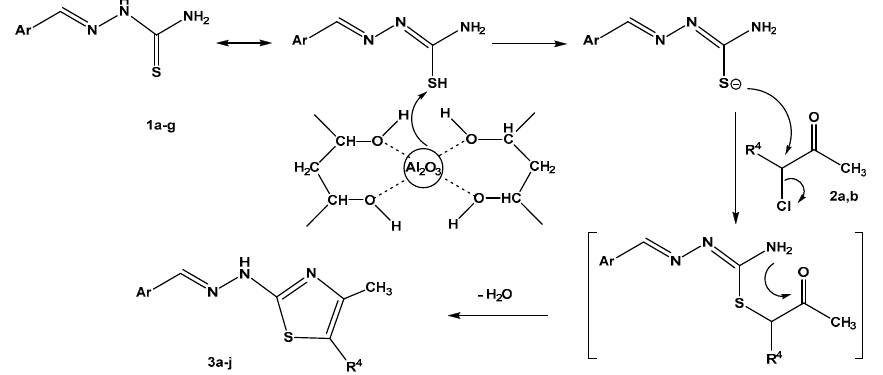
Scheme 3. Plausible mechanism for synthesis of 2-hydrazinothiazoles 3a – j.